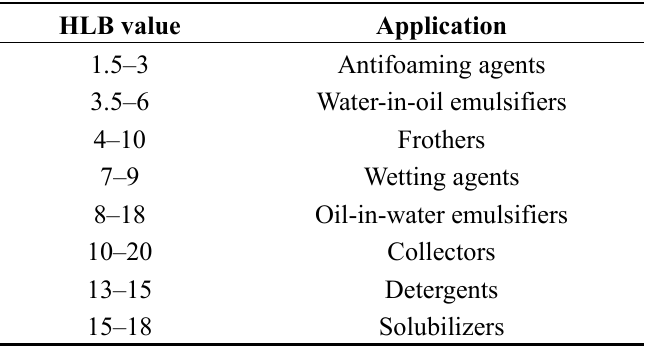
Table 1. Correlation of HLB and application [20].